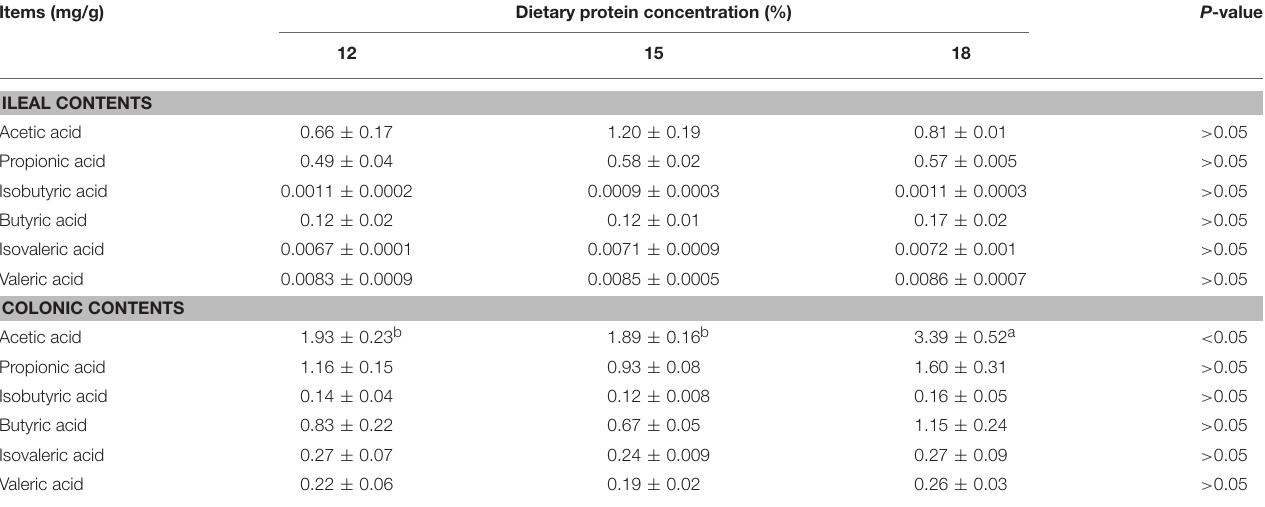
TABLE 1 | Effects of low-protein diets on short-chain fatty acids (SCFAs) concentration in intestinal contents of growing pigs. Items (mg/g) Dietary protein concentration (%) P